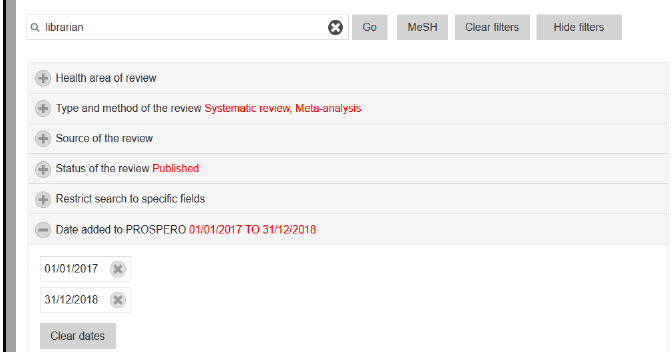
Figure 1 Screenshot of search approach in